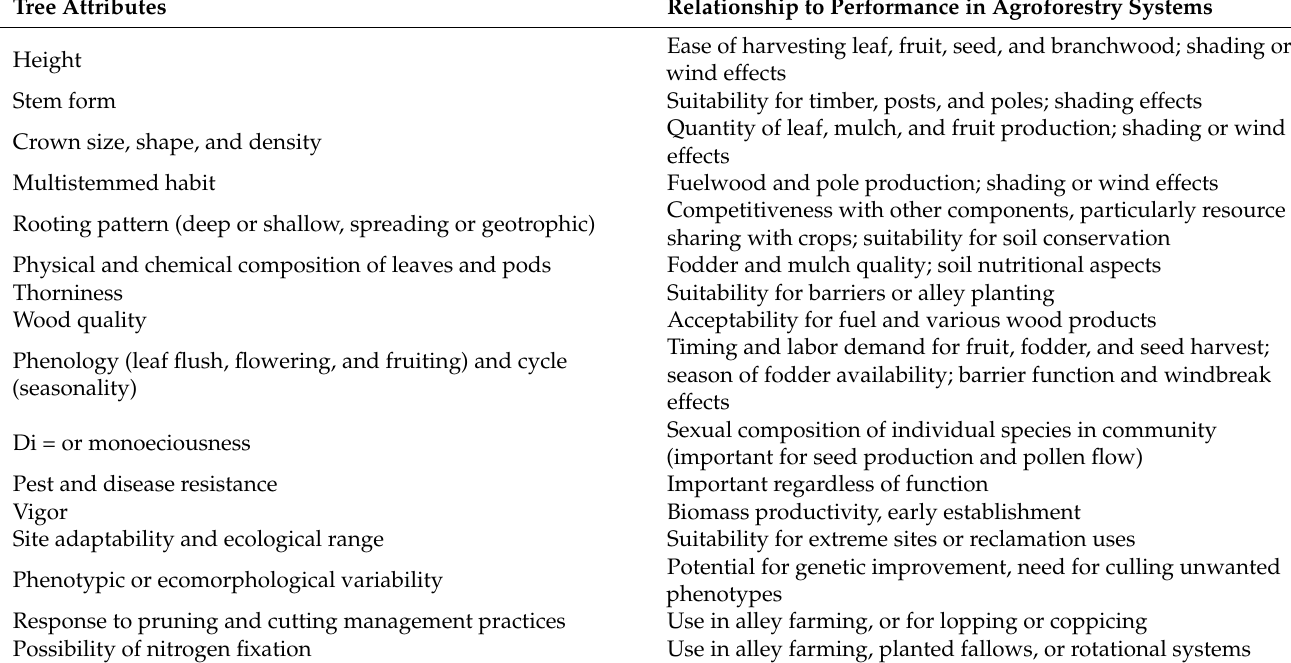
Table 1. An agroforestry framework relating tree attributes to ‘performance’ in an agroforestry system reproduced from Wood [15], which was adapted from Von Carlowitz [16]. Copyright © 1990 John Wiley & Sons,